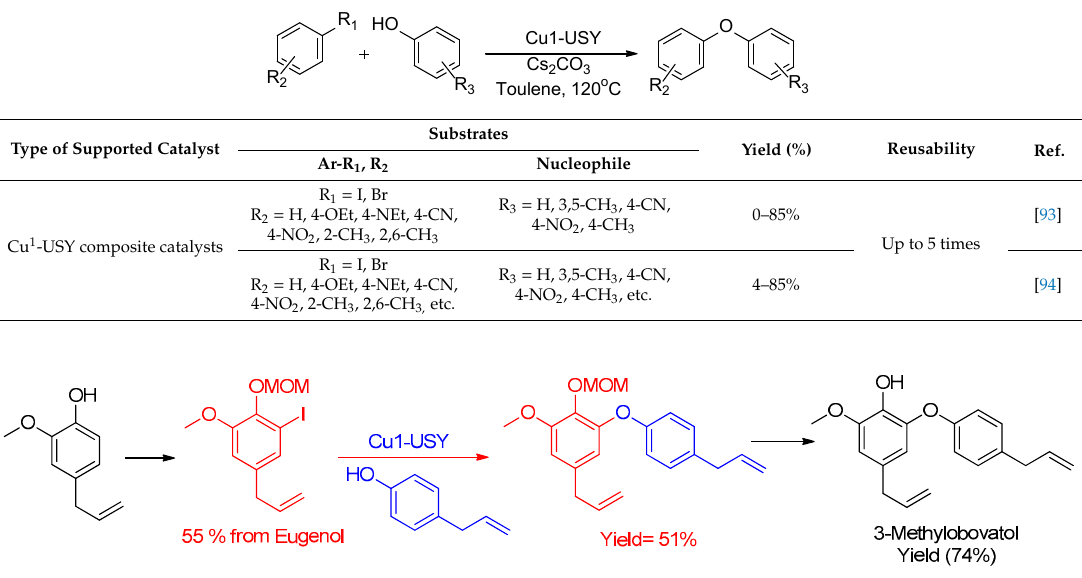
Scheme 30. Total synthesis of 3-methylobovatol via the zeolite-based organic synthesis (ZeoBOS) strategy in the presence of copper (I)-USY.